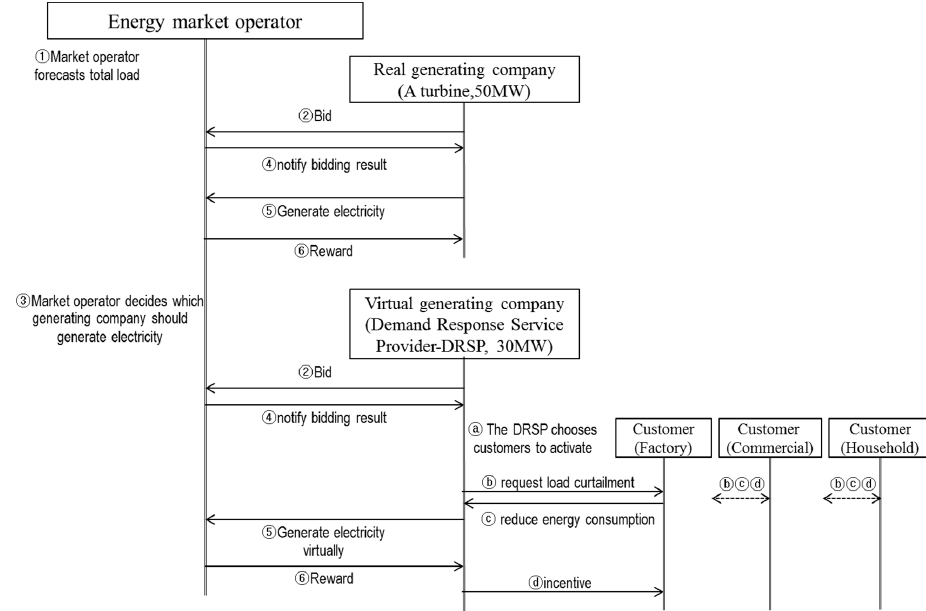
Figure 1. The structure of the incentive-based demand response market. A DRSP virtually generates electricity with actual load reduction from its customers. A DRSP makes incentive contracts with its customers to promote load